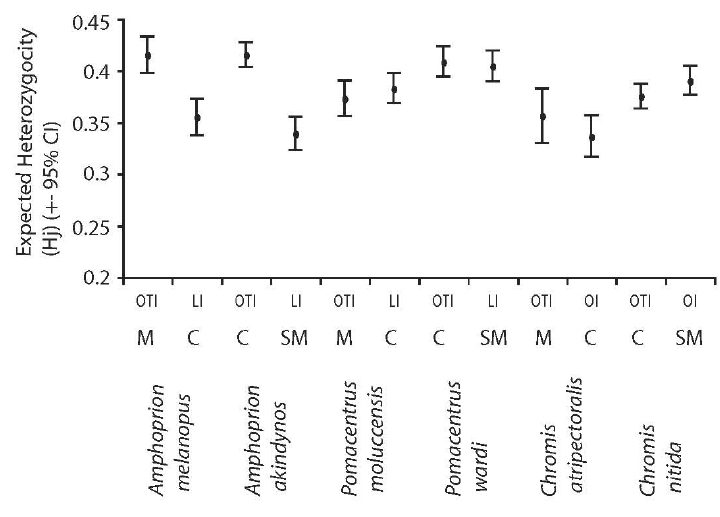
Figure 5. Expected heterozygosity (mean ± 95% confidence intervals) in central (C), southern marginal (M) and northern semi-marginal (SM) populations of the six